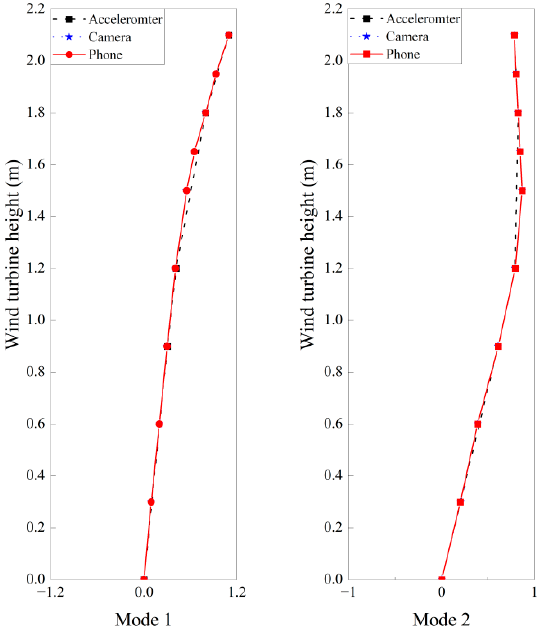
Figure 26. Structural modal shape of wind